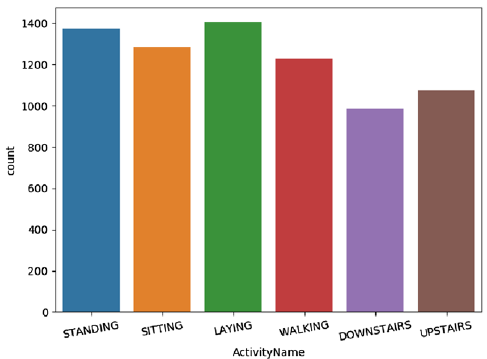
Figure 5. The distribution of activities on UCI HAR